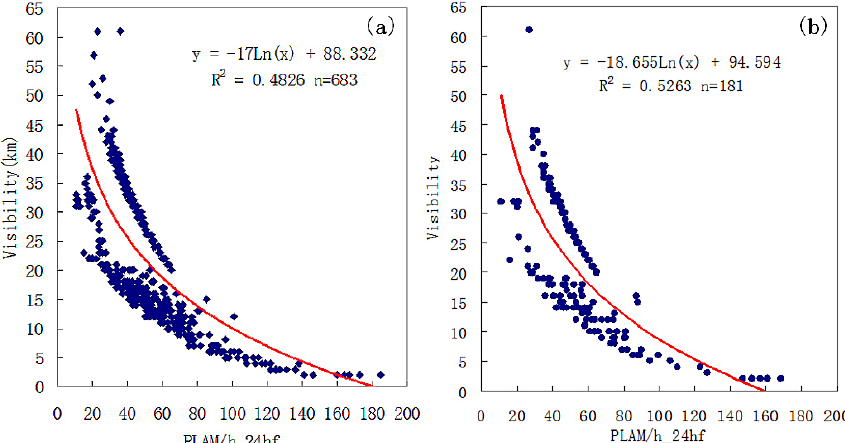
Figure 7. Correlation analysis of the regional PLAM/h index 24h forecasts and visibility during the whole period of pollution in North China at 08:00 (UTC + 8) on 20 July 2014 (a) and 08:00 (UTC + 8) on 22 July 2014 (b) .